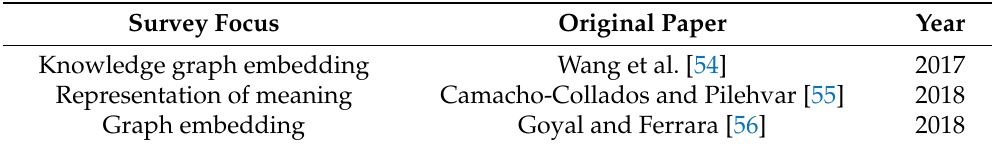
Table 7. List of survey papers of embedding